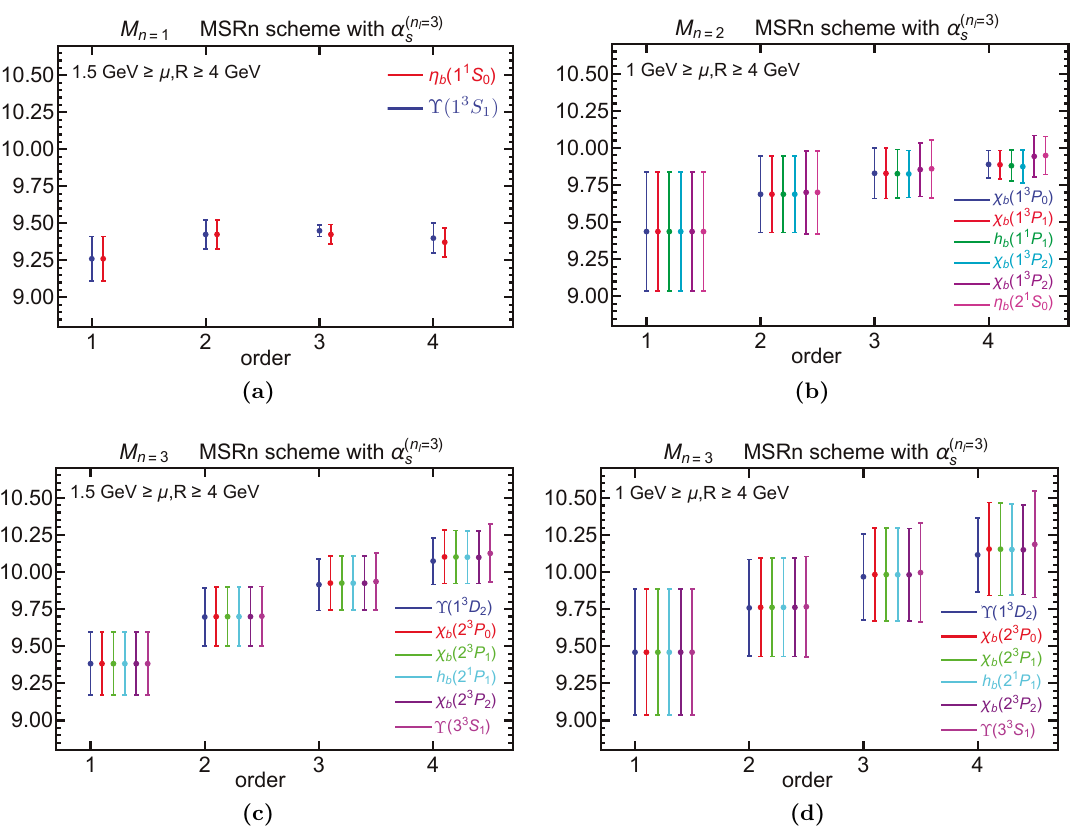
Figure 5. Prediction for the bottomonium masses up to n = 3 for various perturbative orders. The top (cid:12)gures show the two n = 1 states with a scale variation of (cid:22) and R between 1 : 5 GeV and 4 GeV (left plot) and n = 2 with variation between 1 GeV and 4 GeV (right plot). The two lower plots have the same scale variation as the corresponding upper plots, but both show results for n =